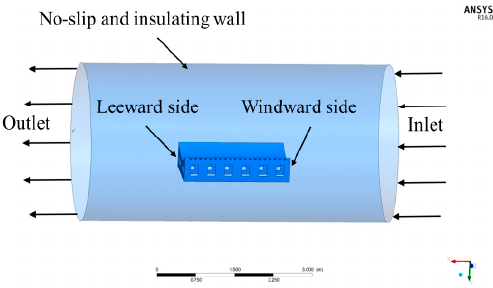
Figure 8. Boundary conditions of the autoclave.